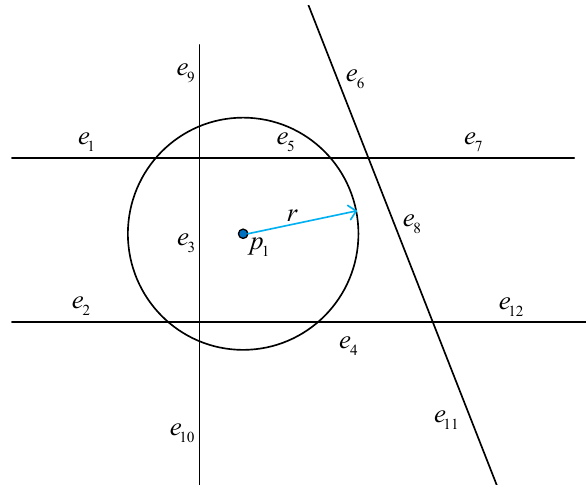
𝑝 (cid:2870) is calculated first, and the result is less than